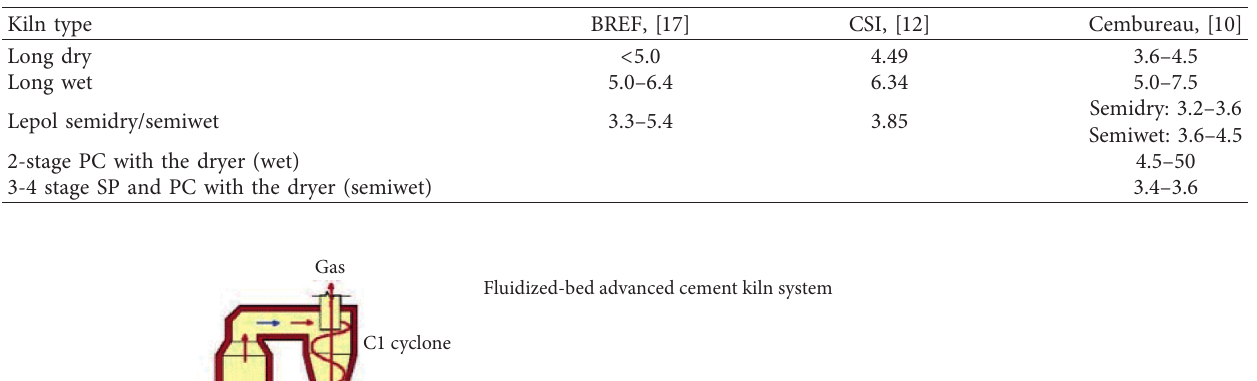
Table 2: Thermal energy consumption for different kinds of kilns (GJ/t).